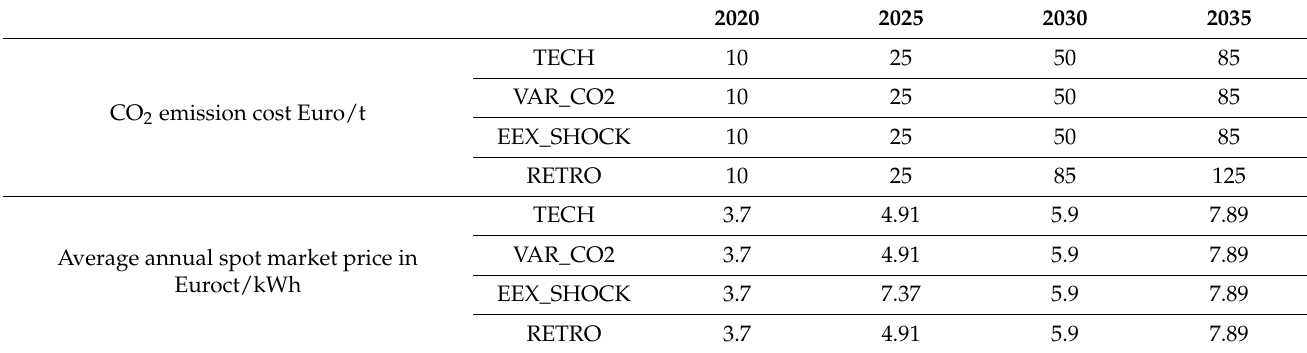
Table 3. CO 2 emission cost and average spot market prices for the calculated scenarios.